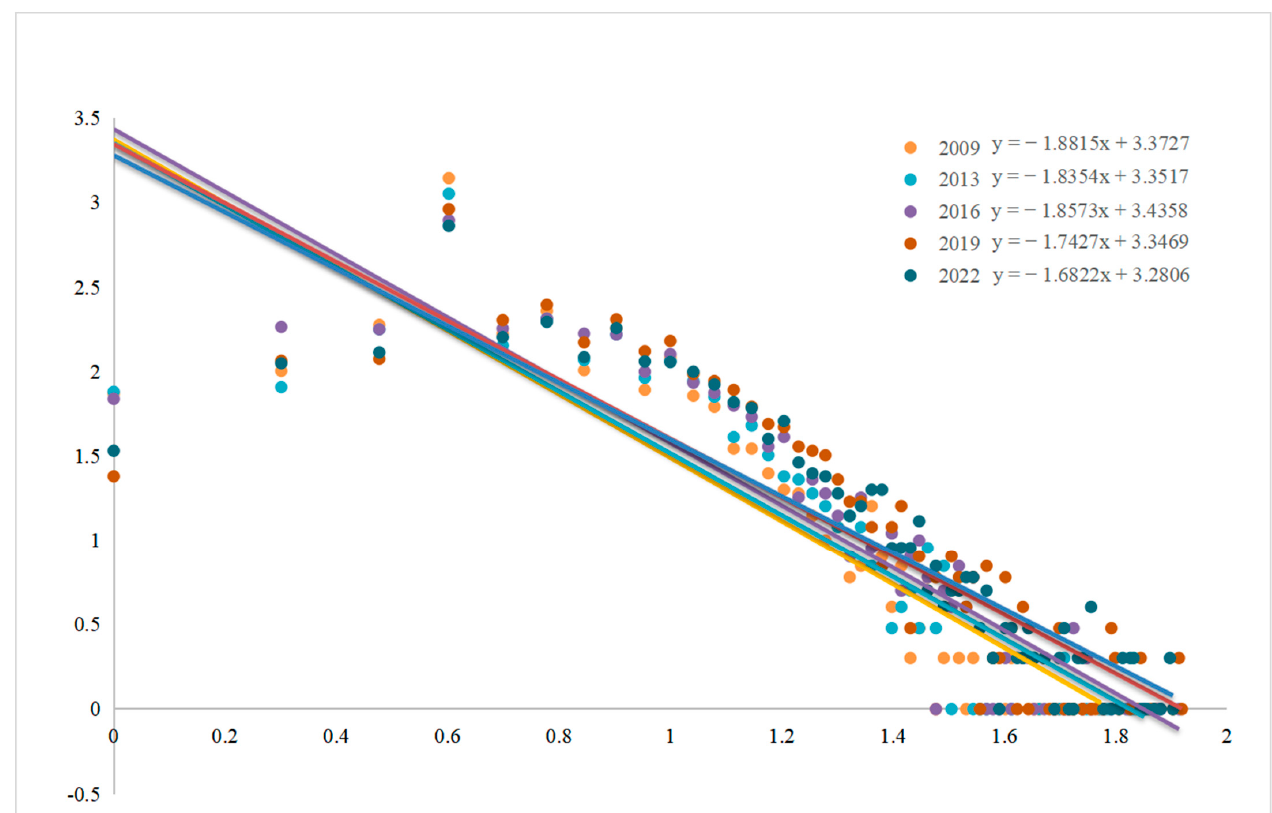
Figure 2. Double logarithmic scatter distribution of degree values and degree distribution.